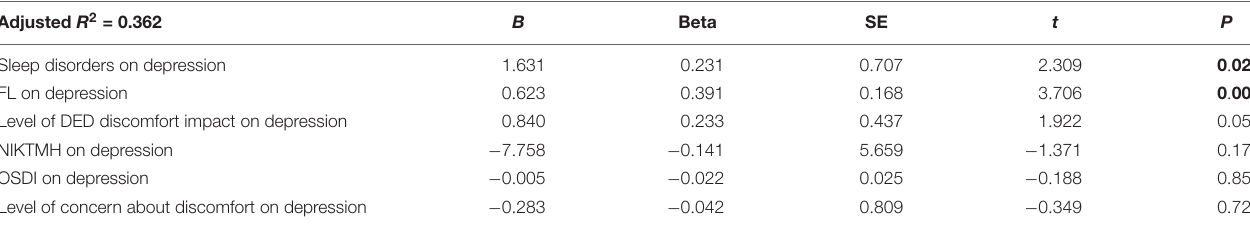
TABLE 11 | Multiple linear regression analysis of association between depression scores, demographic and dry eye parameters in patients aged 41–65. Adjusted R 2 =